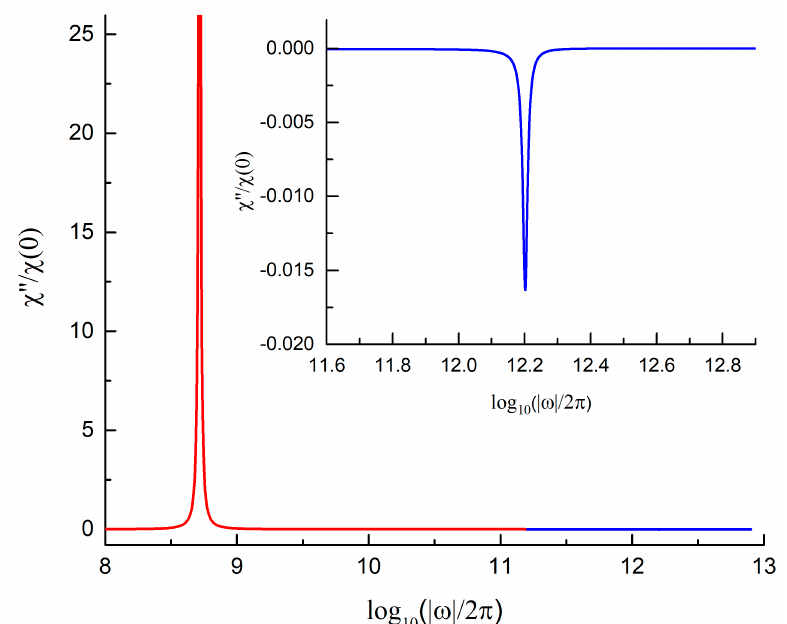
Figure 3. Reduced dynamic susceptibility χ (cid:48)(cid:48) ( ω ) / χ (cid:48)(cid:48) ( 0 ) of the vortex state permalloy circular nanodot vs. logarithmic frequency log(| ω |/2 π ) plotted at the nutation parameter η G = 0.1 ps in consistency with the experimental data [1]. The nanodot thickness is 10 nm, and the radius is 100 nm.